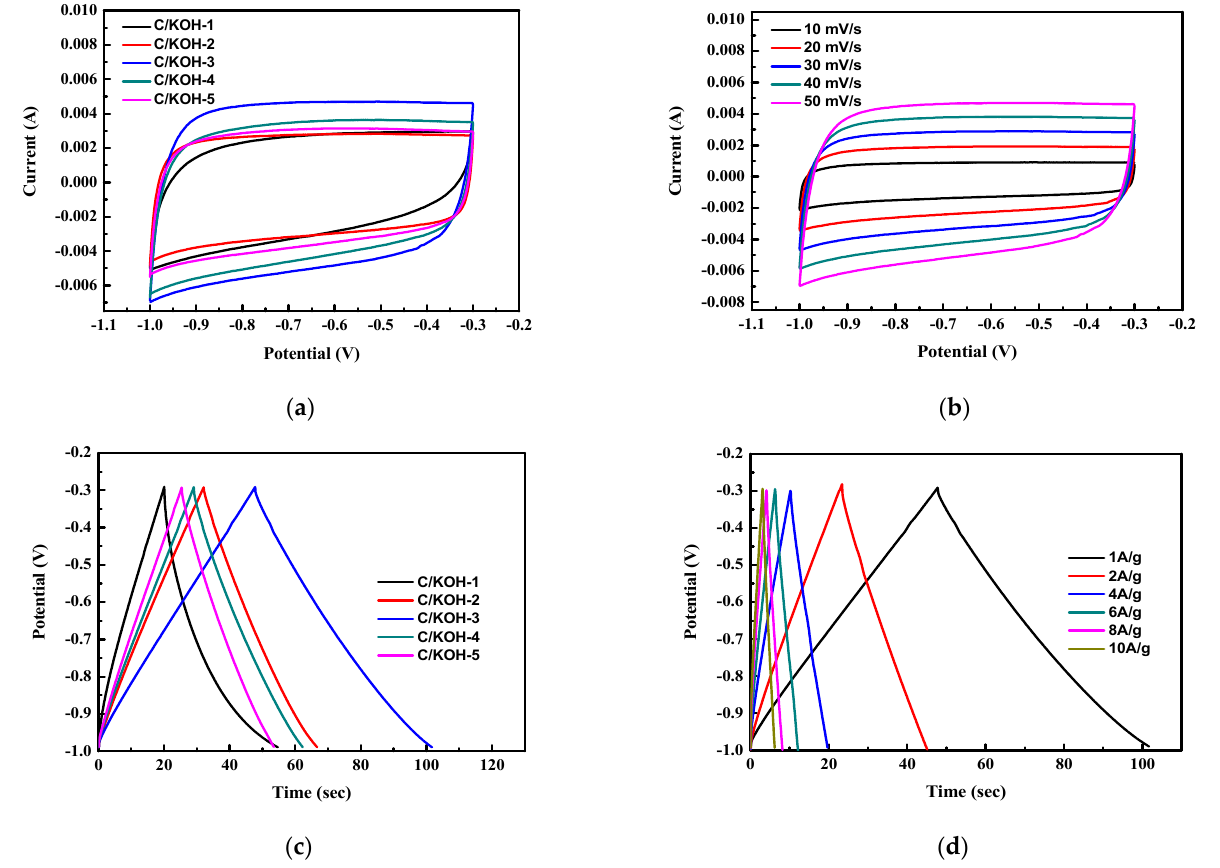
Figure 6. CV curves of undoped AC (C/KOH) electrodes prepared with different weight ratios of KOH at 50 mV s − 1 ( a ), CV curve of the C/KOH-3 electrode at a scan rate of 10–50 mV s − 1 ( b ), charge–discharge analysis at 1 A g − 1 of undoped AC electrode prepared by adding different weight ratios of KOH ( c ) and GCD tests at different current densities ( d ).